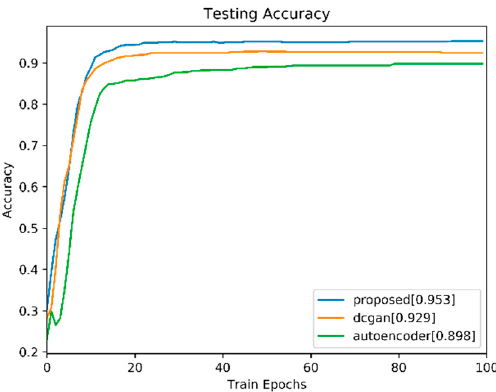
Figure 9. Comparison of testing accuracy of the proposed method, DCGAN, and AutoEncoder in second transferring stage. The batch size is set to 16 while the learning rate of the fine-tuned parameters is set to 0.0002. The three methods are all tested for 100 epochs.